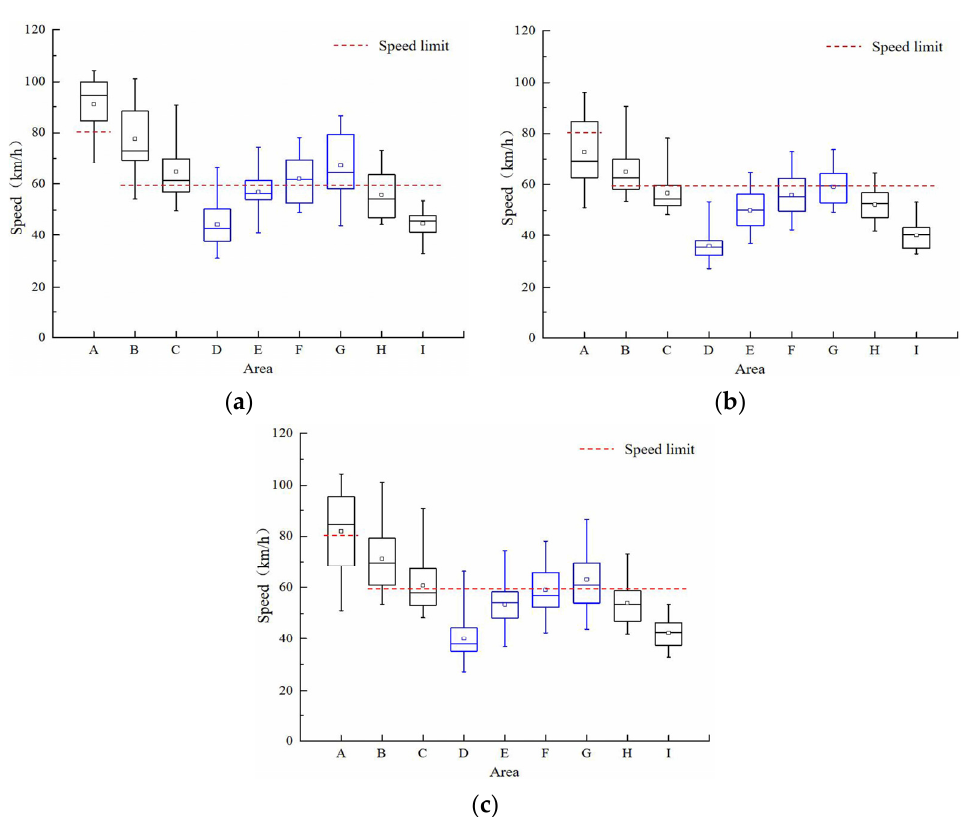
Figure 6. Distribution of vehicle speed for different areas and vehicles. ( a ) Passenger car; ( b ) truck; ( c ) all vehicles. Table 4. Results of vehicle speed statistics for different areas and vehicles.